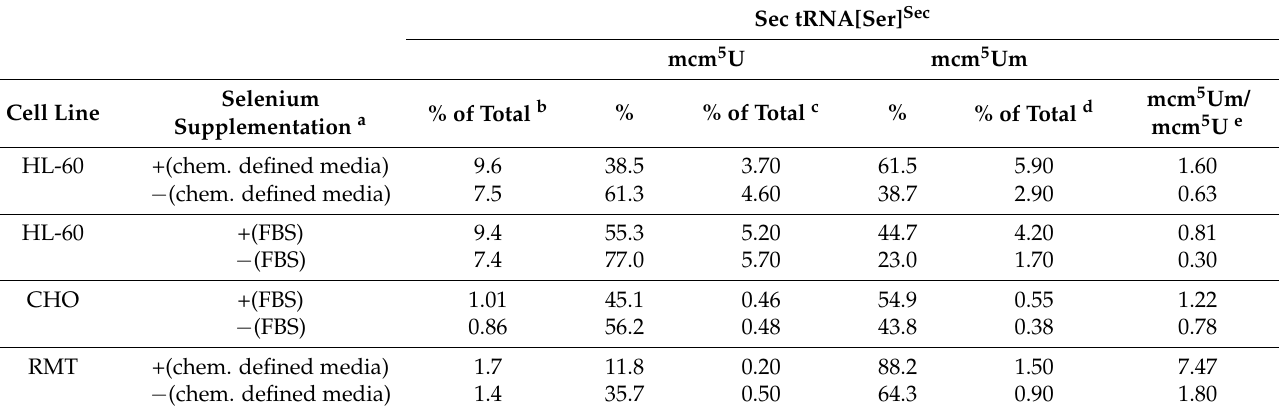
Table 1. Sec-tRNA[Ser] Sec isoforms in cultured mammalian cells.